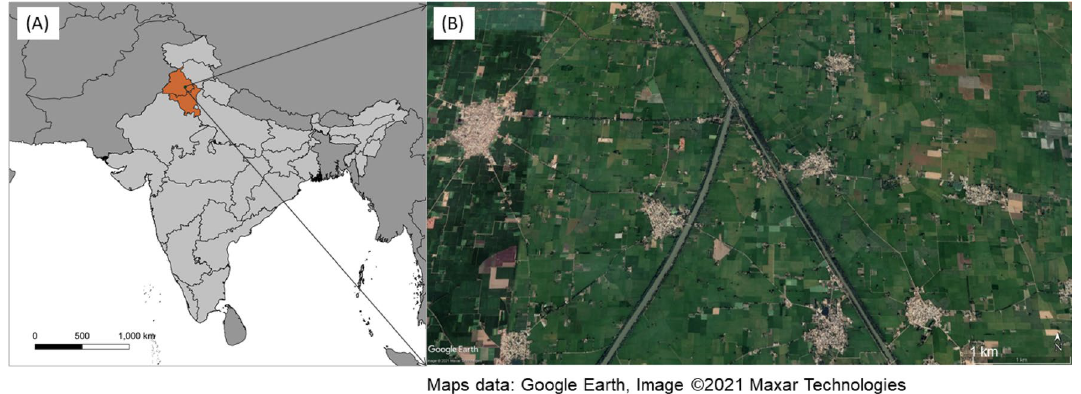
Figure 1. Study region. ( A ) Location map, generated from QGIS 3.16 (QGIS Geographic Information System. Open Source Geospatial Foundation Project. http:// qgis. osgeo. org). Map of India (light grey) indicating the North Indian Punjab region (orange) and the location of the exemplary site shown in ( B ). ( B ) Exemplary landscape by satellite view (Google Earth Pro 7.1, accessed 20.09.2021) In this section, small villages are visible amidst agricultural fields, two major waterways supplying the irrigation system, and small streets connecting the villages.